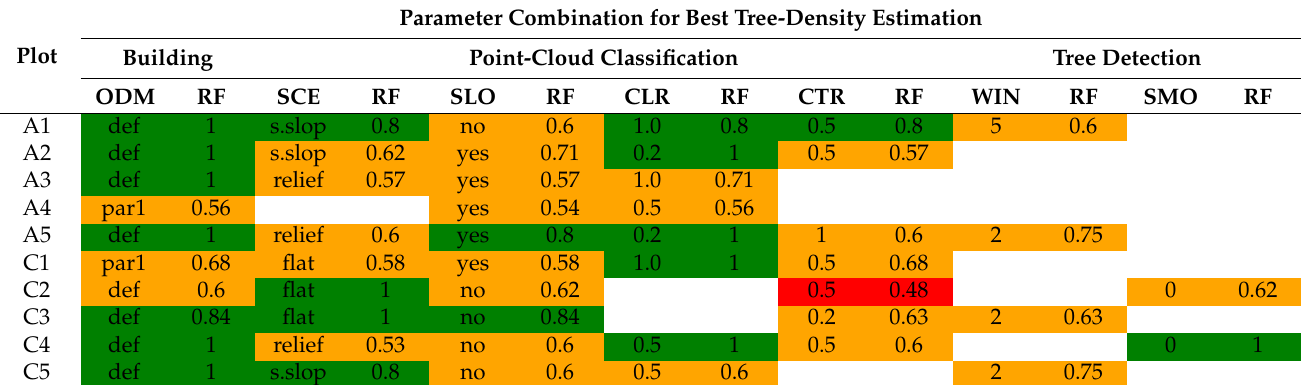
Table 4. Relative frequency values for parameter combination for tree-density estimation. Parameter Combination for Best Tree-Density